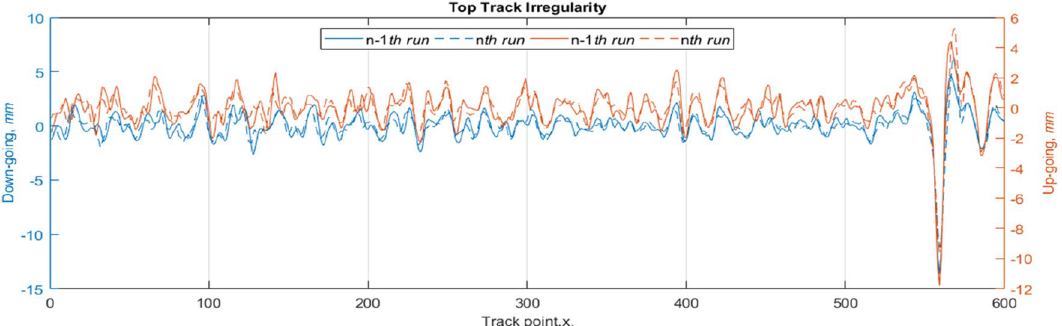
Figure 2. Two consecutive runs of track geometry inspection over the 300-m long track. Irregularity of the track is measured at every 0.5 m and this generates 600 track points as labelled in the position-axis. Note that this is a single set of temporal data across 300-m long track